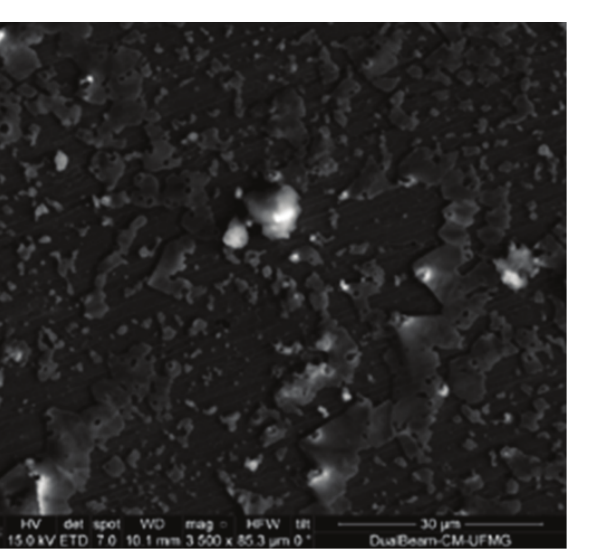
Fig. 4 – SEM micrograph of steel surface after one hour of immersion in a saline solution with 100 µL of EEP